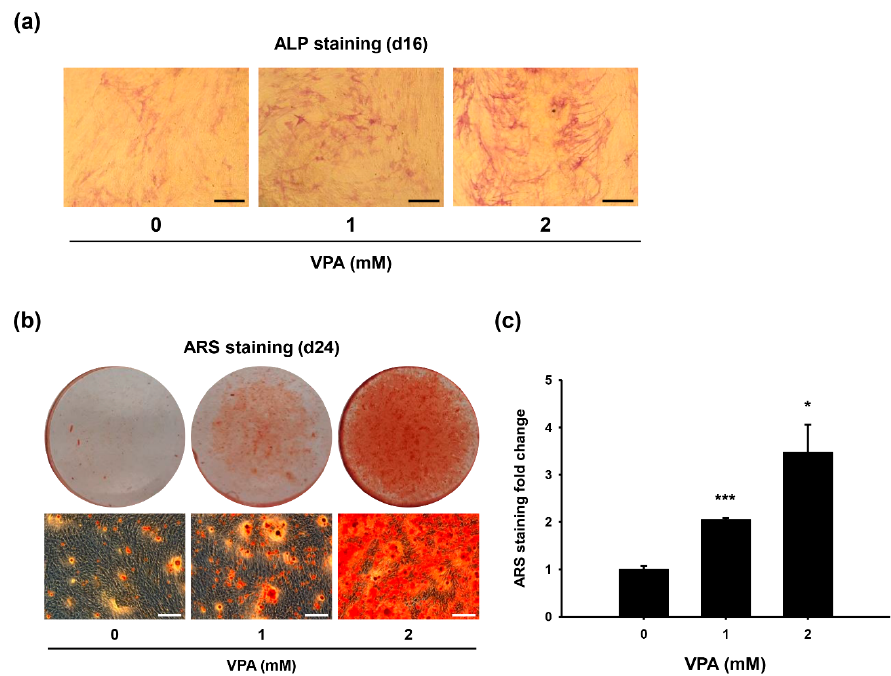
Figure 1. Valproic acid (VPA) promotes osteogenesis via inhibition of histone deacetylase (HDAC). ( a – c ) Human dermal fibroblasts (HDFs) were cultured in the osteogenic medium supplemented with VPA as indicated. ( a ) After culturing for 16 days, cells were stained with alkaline phosphatase (ALP). Scale bar, 200 μ m. ( b ) After culturing for 24 days, calcium deposition was assessed by Alizarin Red S (ARS) staining. Scale bar, 100 μ m. ( c ) Quantified ARS fold change after the treatment of VPA. Error bars indicate the standard deviation ( n = 3 per group) and statistical significance was determined using Welch’s ANOVA with a Games-Howell post hoc test in comparison to the non-treated control, * p < 0.05, *** p < 0.005.